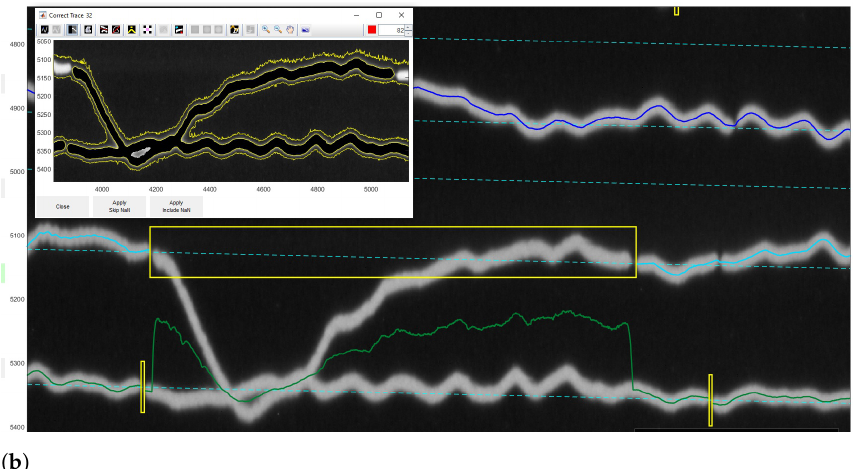
Figure 14. Correcting misclassified traces with wrong direction based on colour and geometric pixel’s characteristics. The pixels on the monochrome image were assigning to categories using threshold values to 1 (white) and all other pixels to 0 (black) for automated detection of lines. The differently colored lines are used to distinguish the segment of trace lines. ( a ) Overlap of line traces unrecognised during digitising: one segment of trace went steeply downwards and merged with another trace. ( b ) Enlarged view of the manually corrected entangled